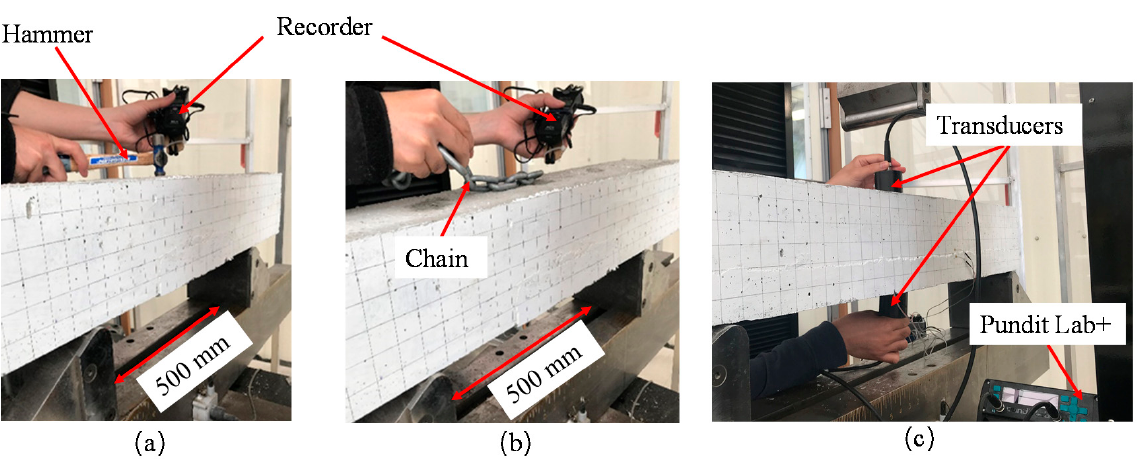
Figure 4. Experimental setup of ( a ) Hammer percussion test ( b ) Modified chain drag test ( c ) Ultrasonic pulse velocity test.